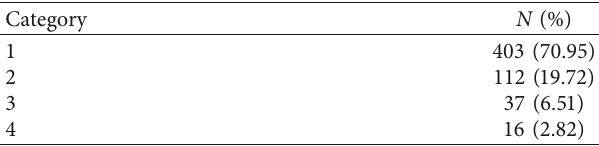
Table 2: Results of the fundus image interpretations. Table 3: Classification of patients based on presenting visual acuity (PVA) and diabetic macular edema